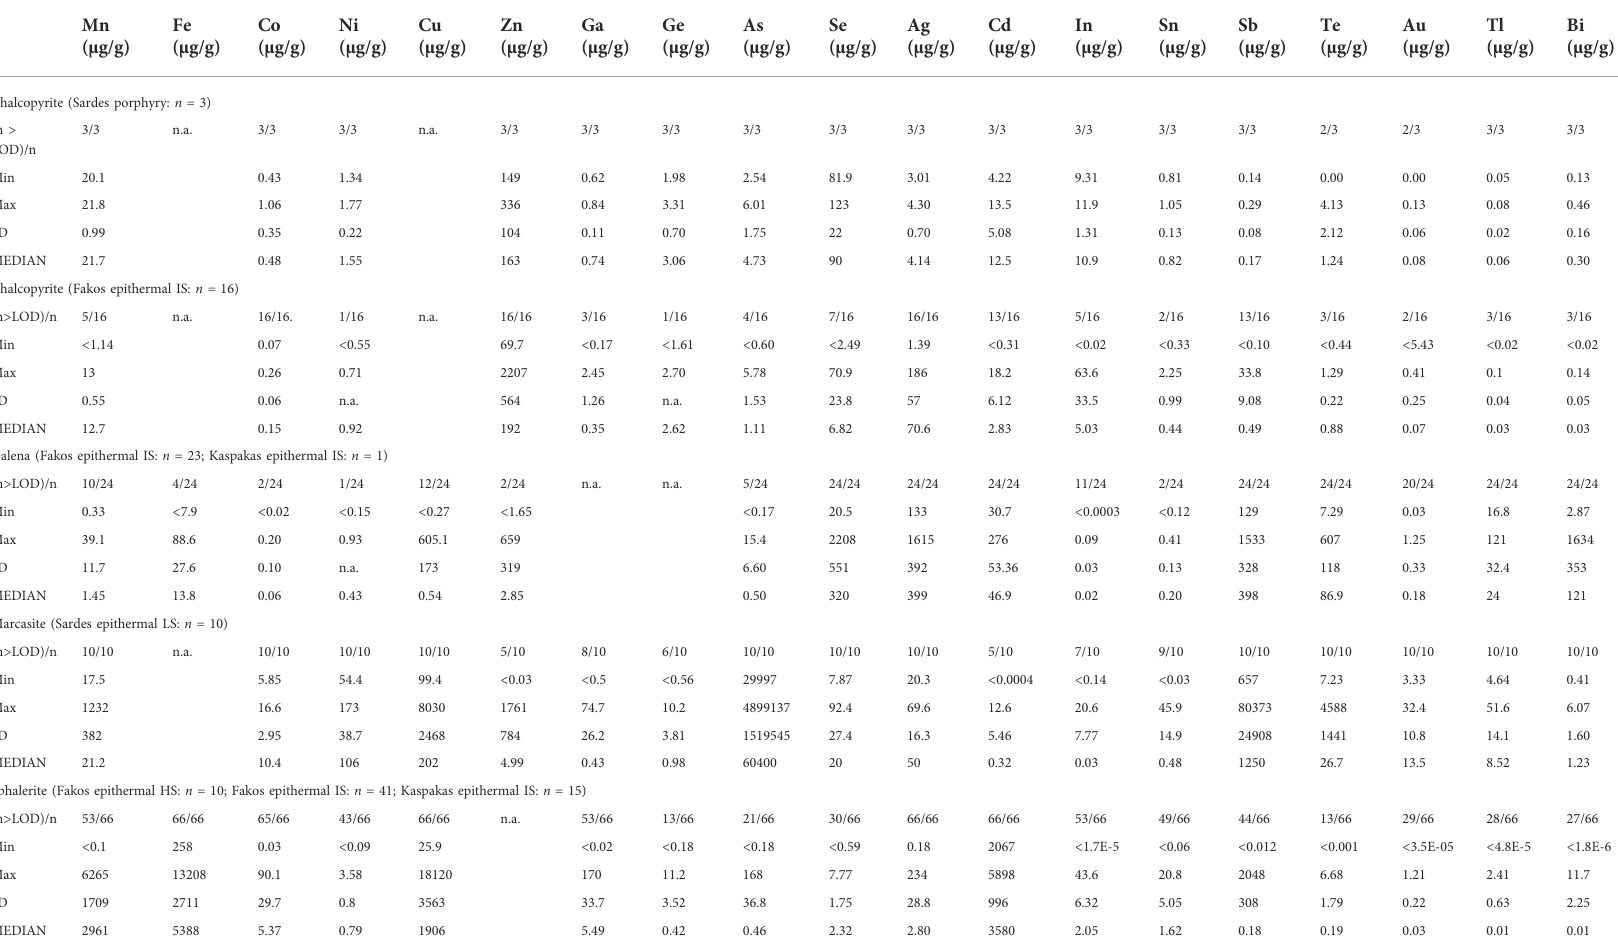
TABLE 5 Summary of results from LA-ICP-MS analysis of minor ore